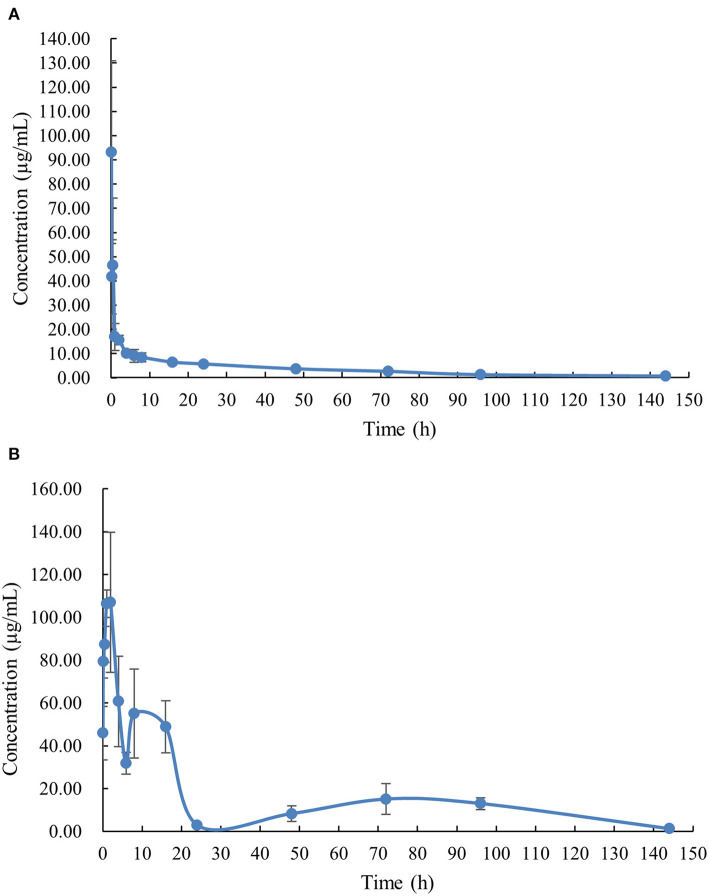
The plasma concentration-time curve with normal scales of doxycycline in channel catfish (Ictalurus punctatus) after intravenous administration at a dose of 5 mg/kg (A) and oral administration at a dose of 50 mg/kg (B).